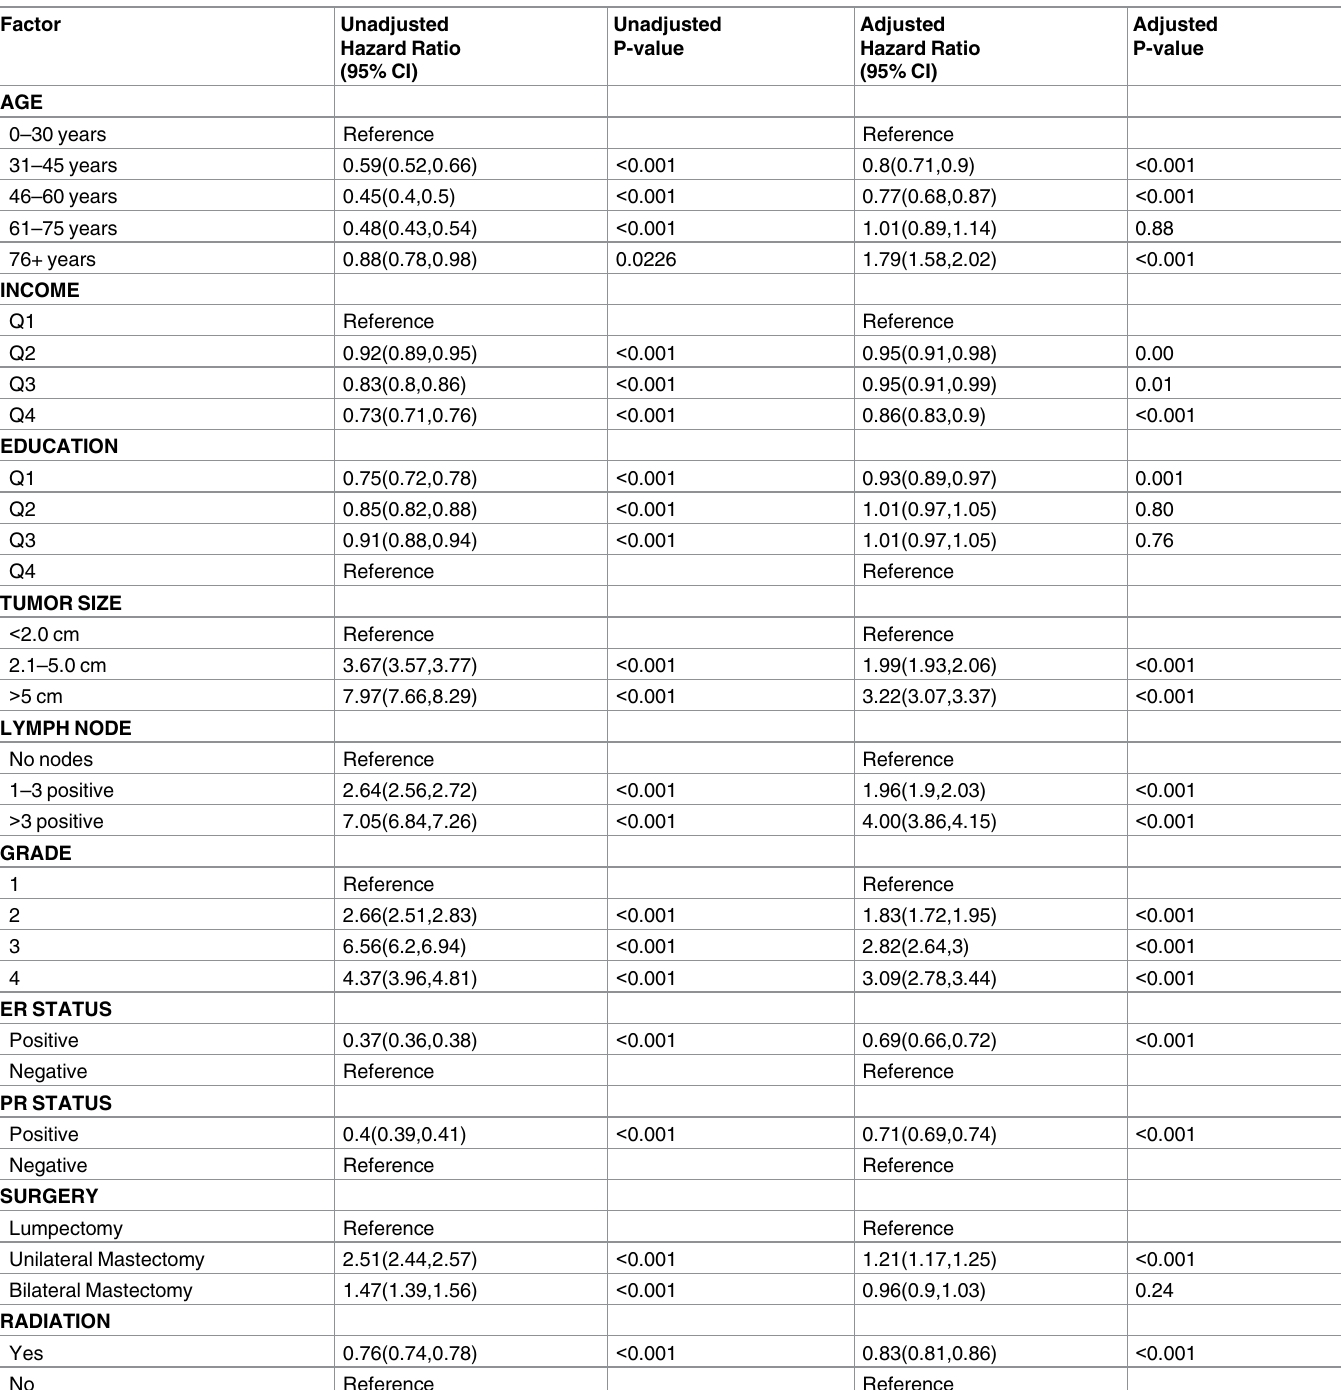
Table 4. Survival analysis of white patients